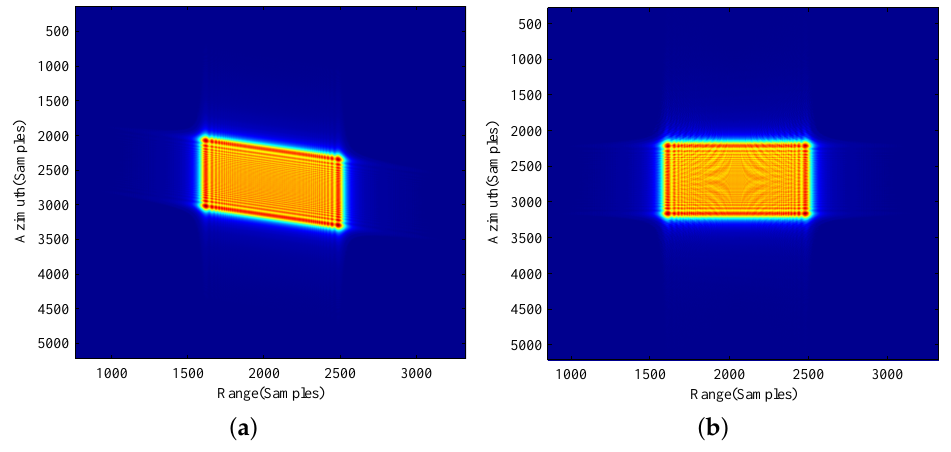
Figure 2. The 2-D spectra of simulated SAR data. ( a ) Original data; ( b ) Data after Keystone Transform